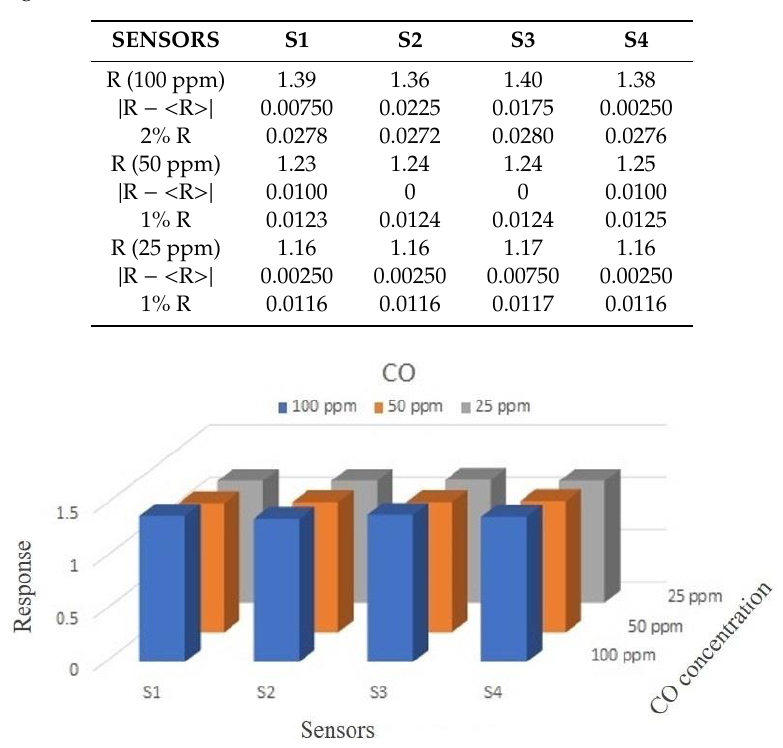
Table 4. Responses R to 25, 50 and 100 ppm of CO; absolute distance from mean value ( | R − < R >| ); and percentage of R below which the value of | R − < R >| stands for all sensors.